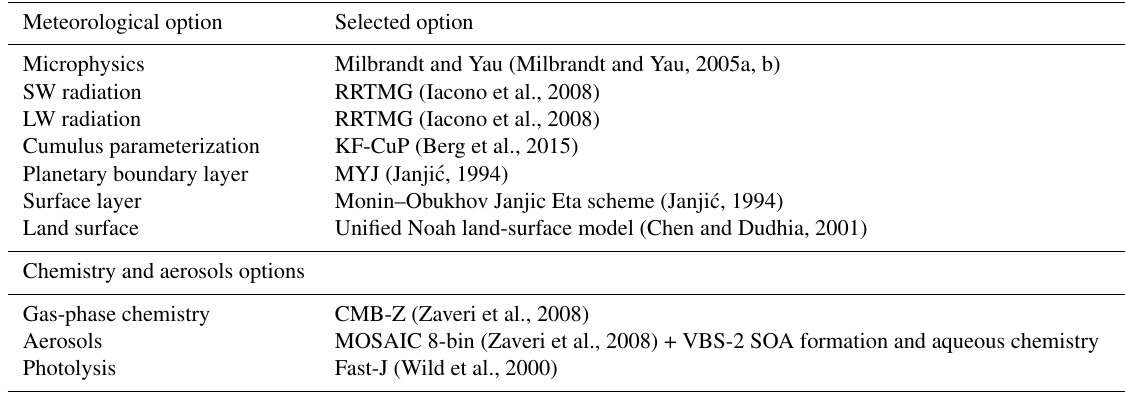
Table 3. Parameterizations and options used for the WRF-Chem